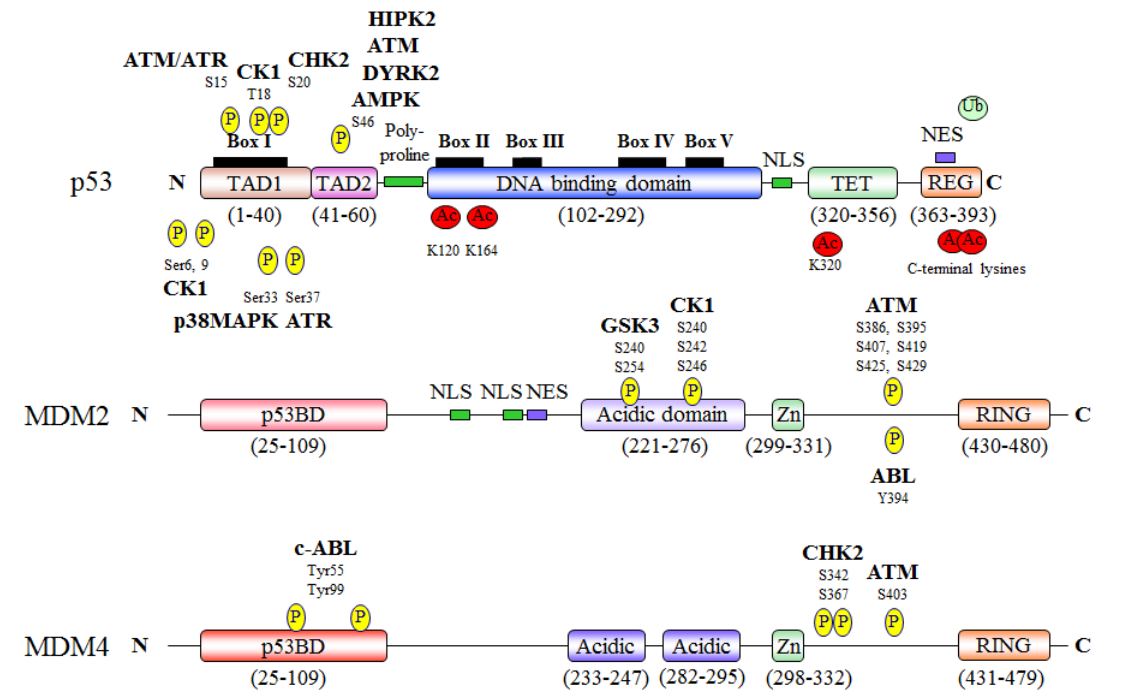
Figure 2. Modular structure and location of key DNA damage-induced phosphorylation sites in p53, MDM2 and MDM4. The p53, MDM2 and MDM4 proteins are shown schematically, highlighting important functional domains. In the p53 structure Boxes I-V represent the highly conserved regions of p53 first highlighted by Soussi and May [201]. Those sites of modification that are directly relevant to the DNA damage (strand break) response are shown (yellow ellipses), together with the protein kinases(s) known to phosphorylate them. The sites of acetylation (red circle) and ubiquitylation (green circle) in p53 are also indicated. Comprehensive lists of the post-translational modifications in these proteins are available elsewhere [14, 52, 62, 65, 202,